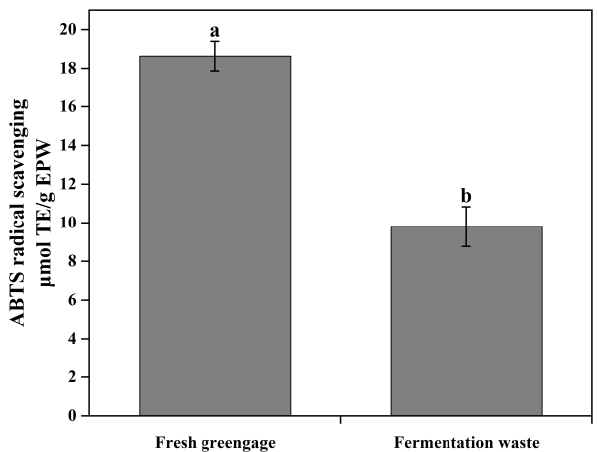
Figure 6. ABTS radical scavenging of fresh greengage and its fermentation waste. The data are shown as the mean values of three determinations (n = 3) ± standard deviation (error bars). Different letters indicate that they are significantly different at p < 0.05 according to ANOVA analysis.